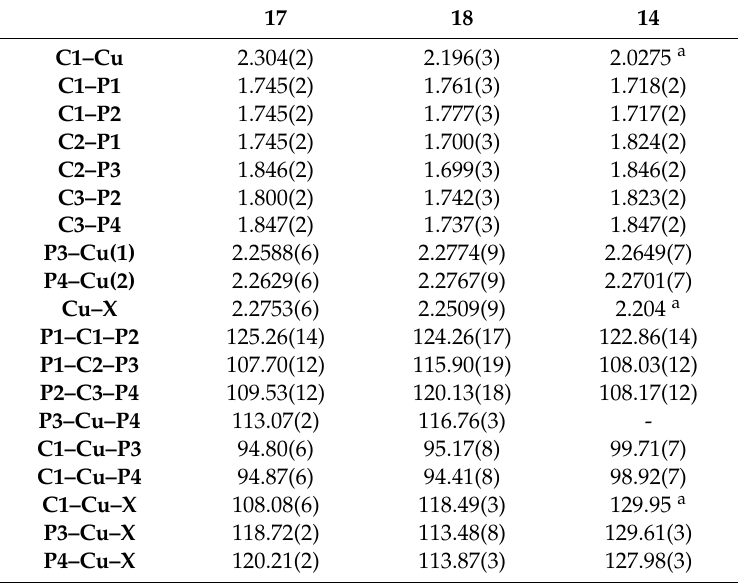
Table 3. Selected bond distances [Å] and angles [ ◦ ] for 14 , 17 and 18